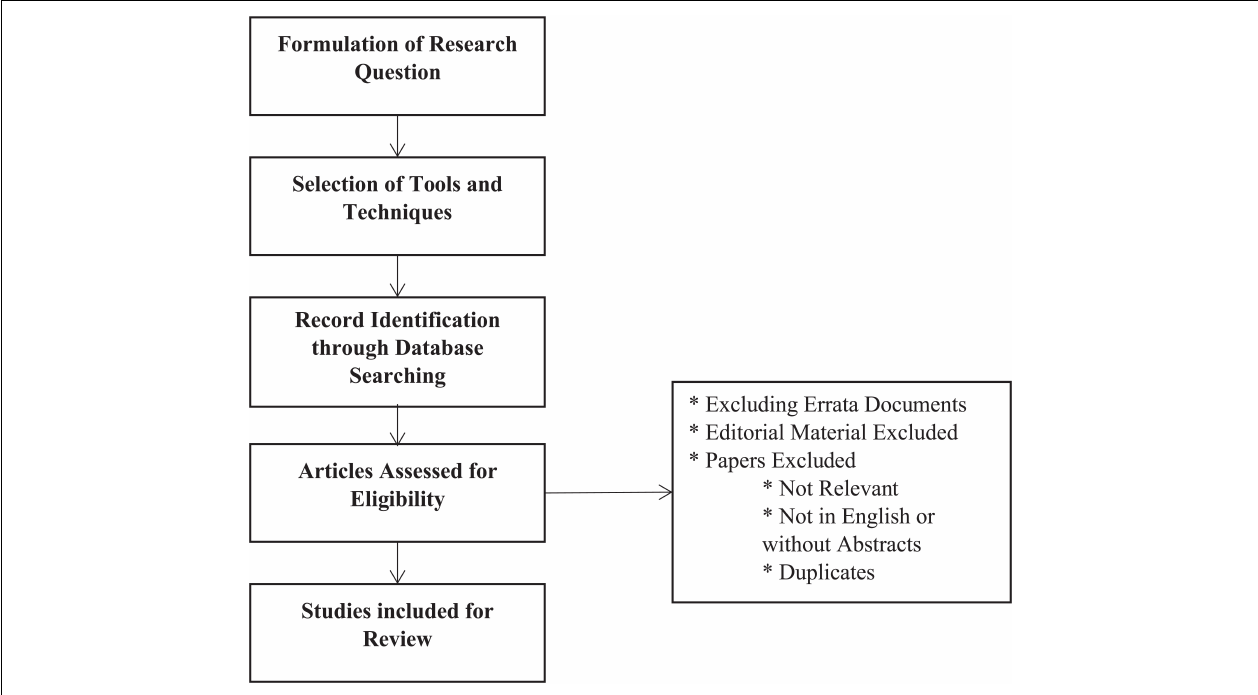
FIGURE 2 | Sample selection